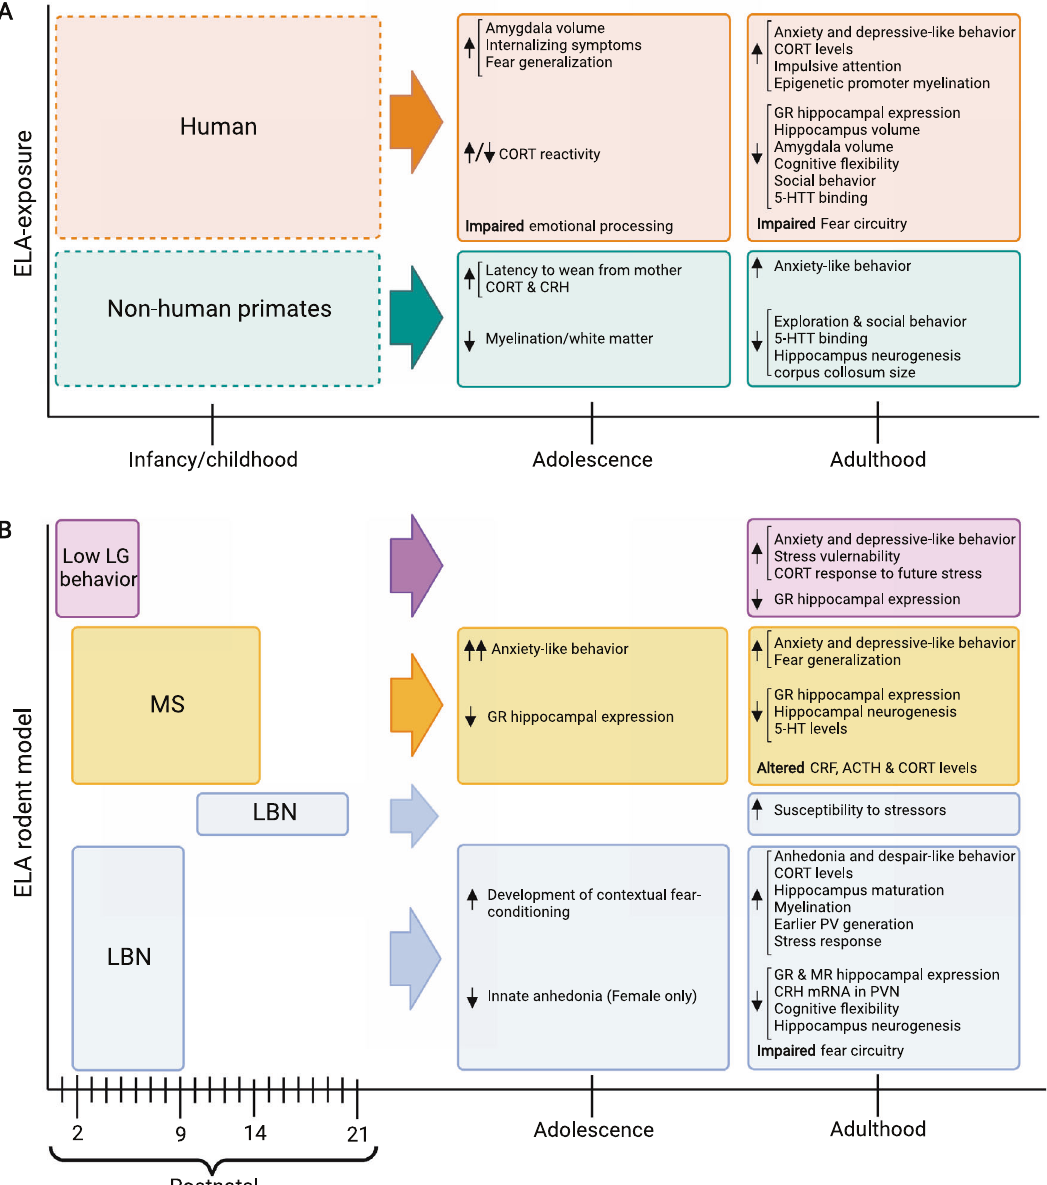
Fig. 1 Behavioral, neurobiological, and physiological outcomes of postnatal ELA exposure in adolescence and adulthood. A ELA outcomes in humans and non-human primates. Dotted lines indicate the range of time ELA can occur. B ELA outcomes in rodents. The effects of different types of ELA models and the time period during which they are generally applied are indicated during P0 – 21. Adolescence and adulthood outcomes are listed for each species and